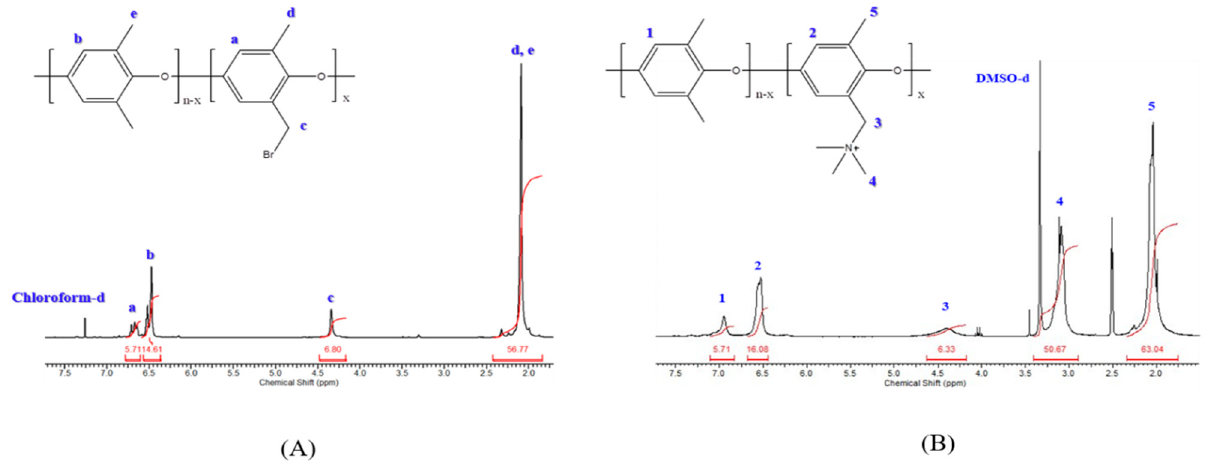
Figure 2. 1 H–NMR spectra of ( A ) brominated polyphenylene oxide (Br–PPO) and ( B ) polyphenylene oxide containing quaternary ammonium (QA – PPO).